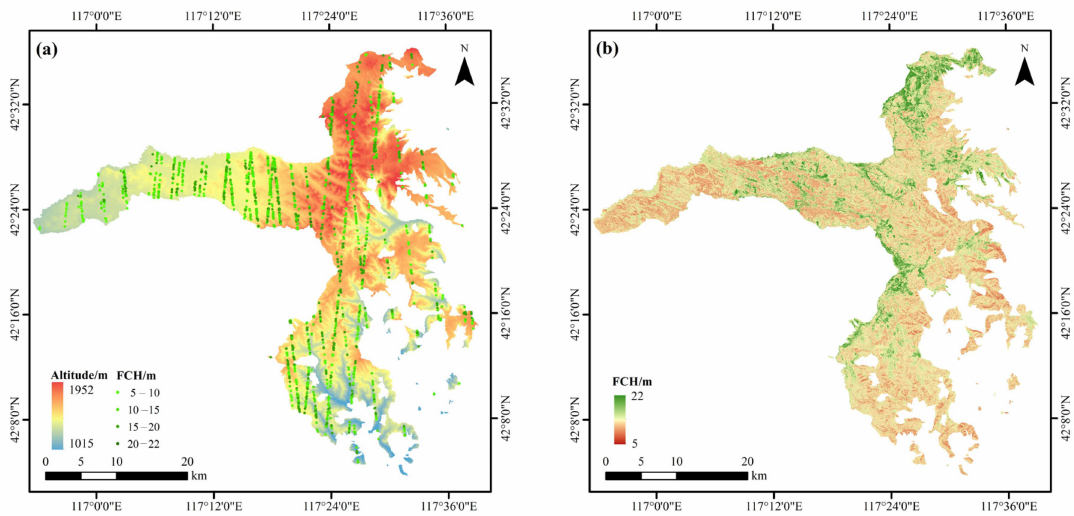
Figure 8. Spatial distributions of forest canopy height predictions in Saihanba, obtained using stacking, and consisting of ( a ) predictions from the ICESat-2 footprint area, overlaid on altitude imagery; ( b ) the spatial distribution of the forest canopy height derived from